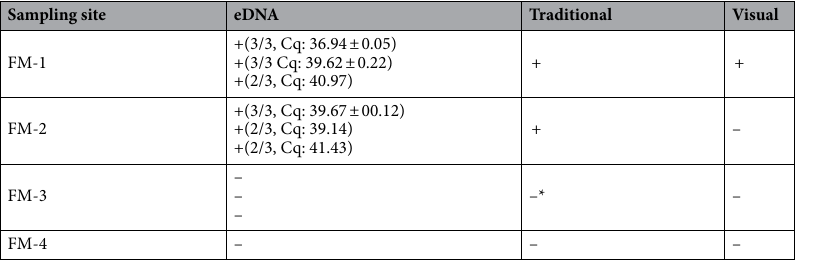
Table 3. Comparison of the results of eDNA analysis using samples from Fushimi and traditional survey methods. The column “eDNA” indicates whether eDNA was detected by real-time PCR. The numbers in parentheses are the number of positive replicates and the average and standard error of Cq values (if positive in 2/3, only the average is shown). The column “Traditional” shows data from the regular visual survey of L. humile conducted by the Kyoto Prefectural Institute of Public Health and Environment, and * indicates the site where individuals were observed until 2 years ago but where they have not been observed in the last 2 years. The column “Visual” indicates whether L. humile individuals were visually observed on the day of soil sampling. The raw data are presented in Table